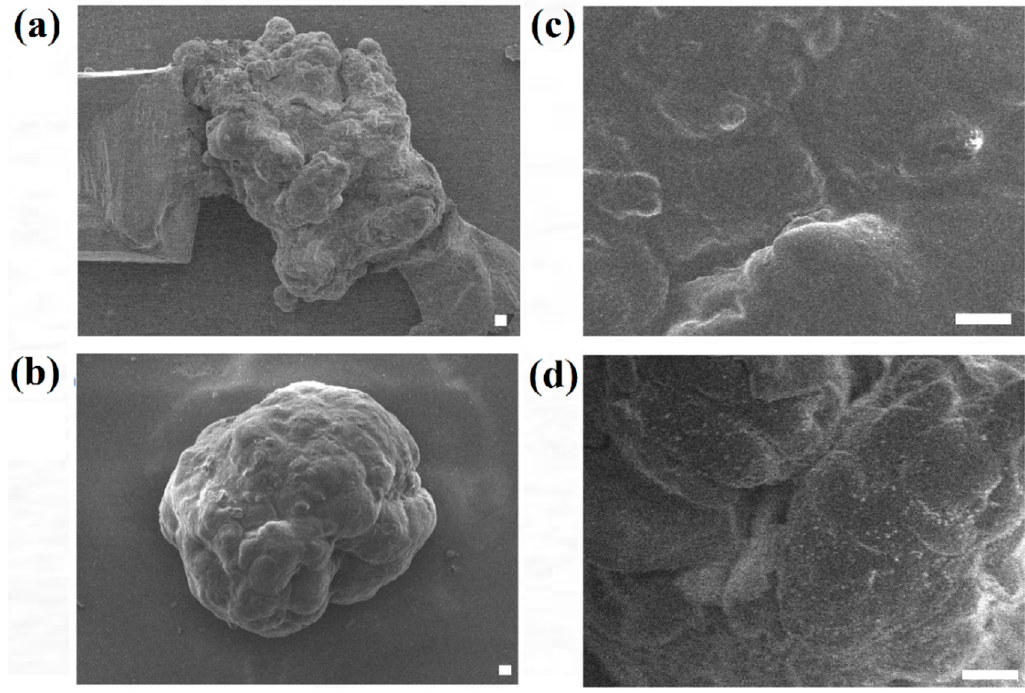
Figure 6. Field emission-scanning electron micrographs of ( a , c ) HaCaT and ( b , d ) ORL-48 microtissue after 15 days of culture at ( a , b ) 300 × and ( c , d ) 1500 × magnifications, respectively (Scale bar: 10 µ m).